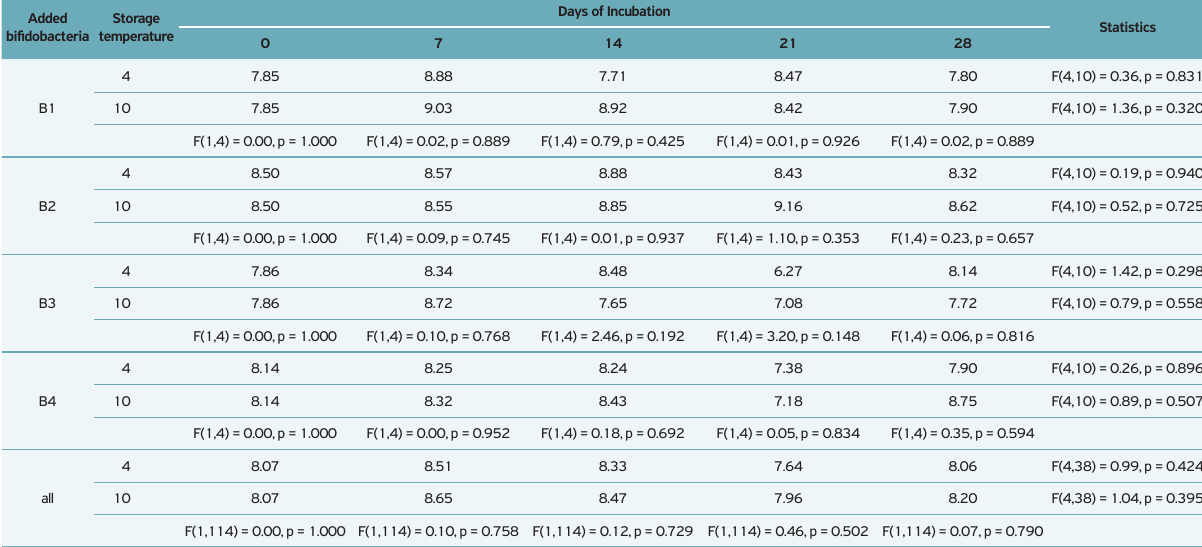
Table 2. Mean counts of Streptococcus thermophilus from fermented milk (added to bifidobacteria cultures) stored at 4 and 10°C for 28 days, obtained by M17 culture media by conventional plating.